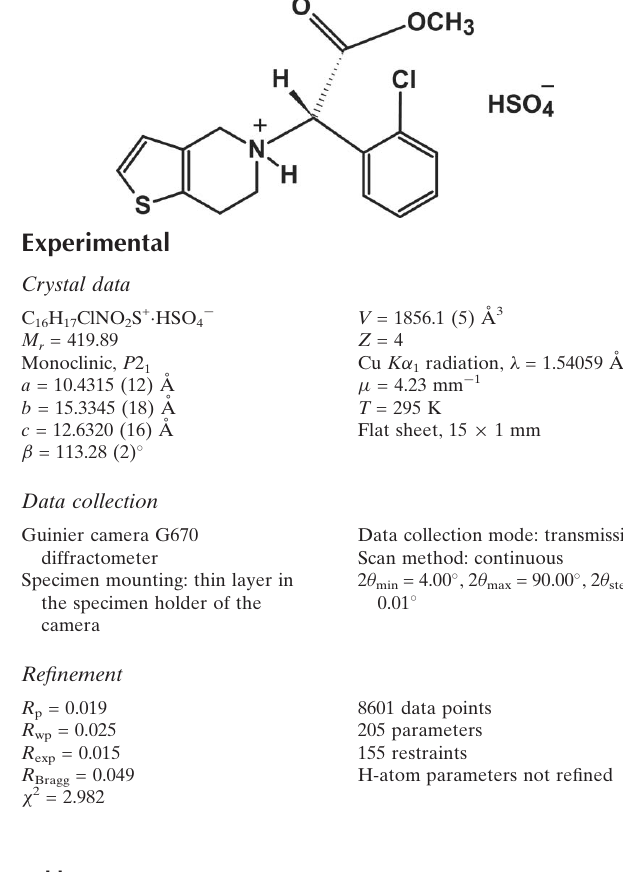
Hydrogen-bond geometry (A˚ , (cid:4) ). D —H (cid:2)(cid:2)(cid:2)